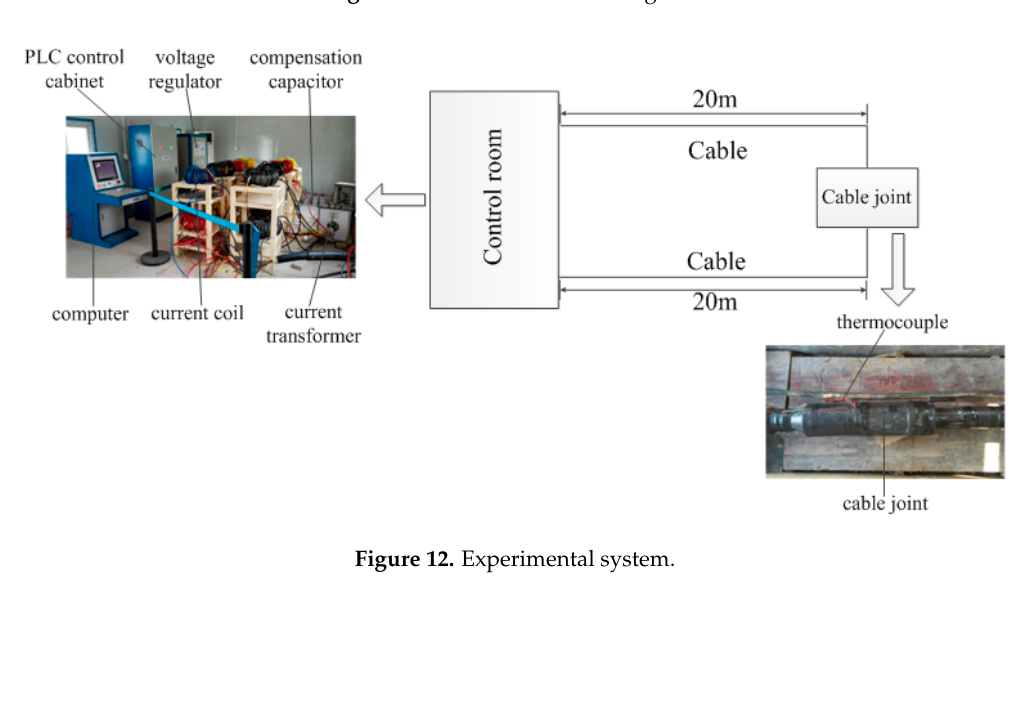
Figure 11. Cable installation diagram.